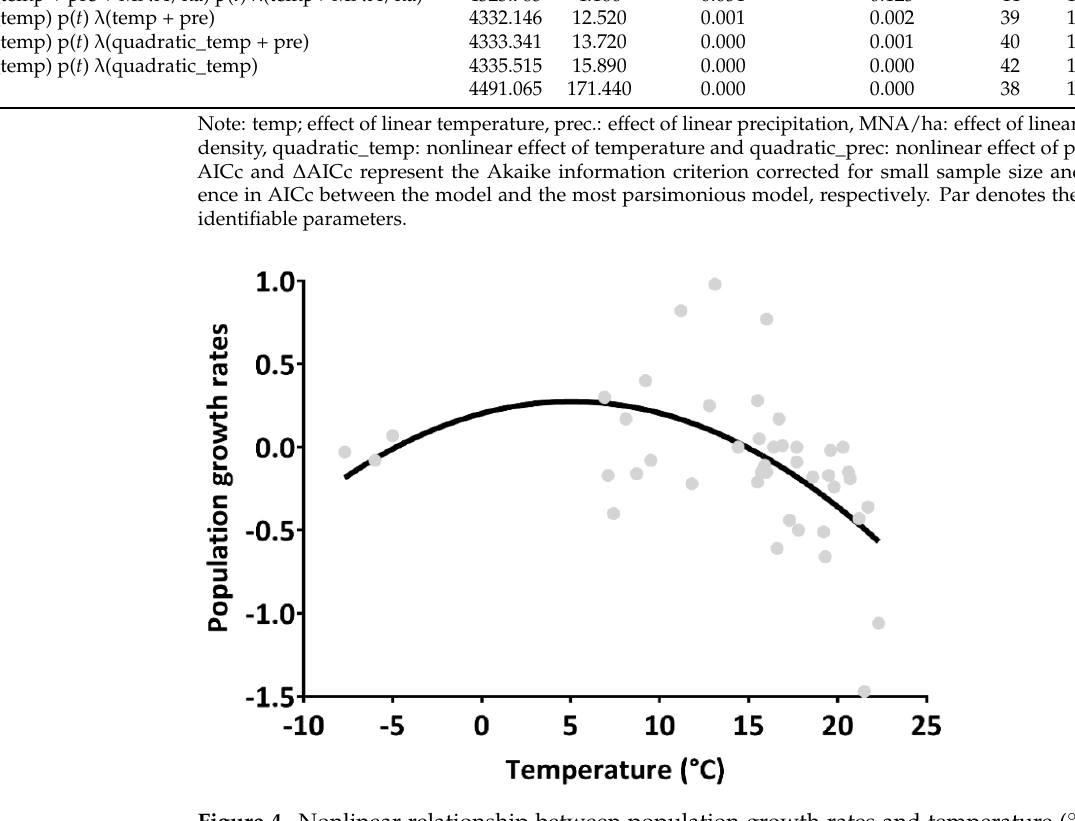
Figure 4. Nonlinear relationship between population growth rates and temperature ( ◦ C, i.e., the average daily temperature of each trapping interval between two successive trapping sessions) in the generalized least-squares models for of Mongolian gerbils ( Merionus unguiculatus ) in Houhatai,